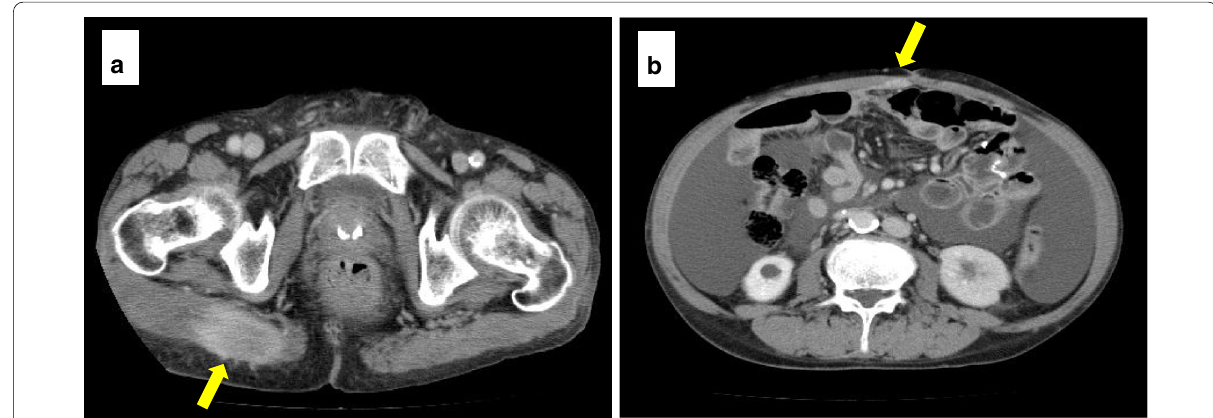
Fig. 2 Abdominal contrast-enhanced computed tomography images 6 months after gastrectomy. a Computed tomography scan shows a solid mass (arrows) measuring 52 mm